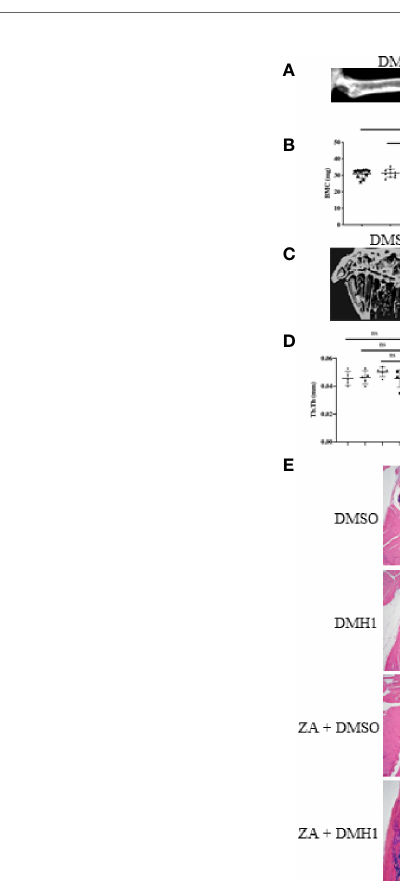
FIGURE 2 | BMP Receptor Antagonist DMH1 Does Not Impair Bone. Twenty male 8 week old C57Bl6/j mice were placed into four groups (n=5 each) where they received a 6-week osmotic pump of DMSO or DMH1 alone or in addition to Zoledronic acid. 6 and 12 weeks after initial treatment with the osmotic pumps, the animals were analyzed by DXA Faxitron X-ray. At week six, with osmotic pump with DMH1 or DMSO expired, and the animals received an additional injection of zoledronic acid then monitored for another 6 weeks. (A) DXA representative µCT images of femurs at week 6. (B) BMC and BMD graphs of DXA data from week 6. (C) Representative image of each cohort showing the reconstruction of a cross section of the femur at week 12. (D) Analysis of µCT values of the femoral trabecular bone at week 12. (E) Representative H&E images of femur bone with emphasis in trabecular area. Scale bars for 4X, 10X and 20X are 200µm, 100µm and 50µm respectively. Statistical signi fi cance was determined using One-way ANOVA test and error bars indicate